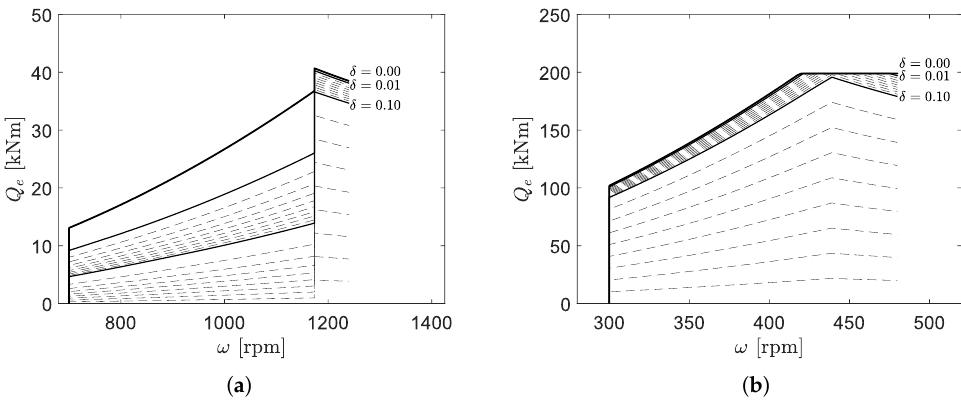
Figure 17. Q e ( ω , δ ) tables for NREL 5-MW ( a ) and DTU 10-MW ( b ) reference turbines.